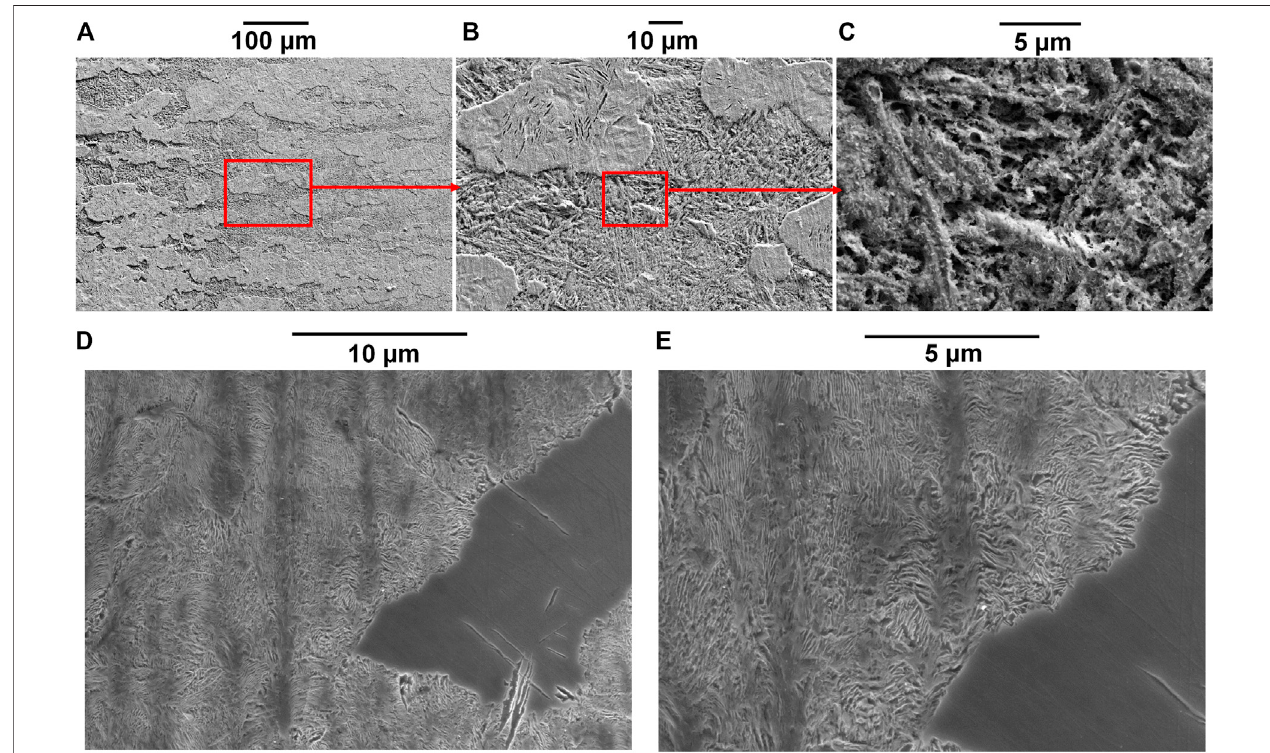
FIGURE 10 | SEM micrographs of samples after heat treatment with the cooling rate 10 ° C/s [ (A) after anodic polarization at 0.15 V vs. OCP with a crevice gap of 50 μ m; (B) magni fi cation of A; (C) magni fi cation of B; (D) etched surface of the same sample as Figure 2D ; (E) magni fi cation of D].